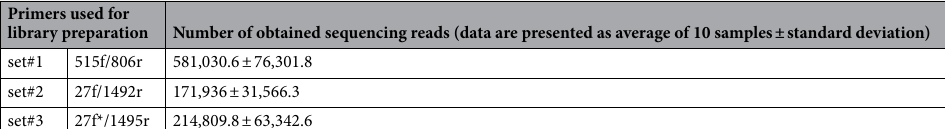
Primers used for library preparation Number of obtained sequencing reads (data are presented as average of 10 samples ± standard